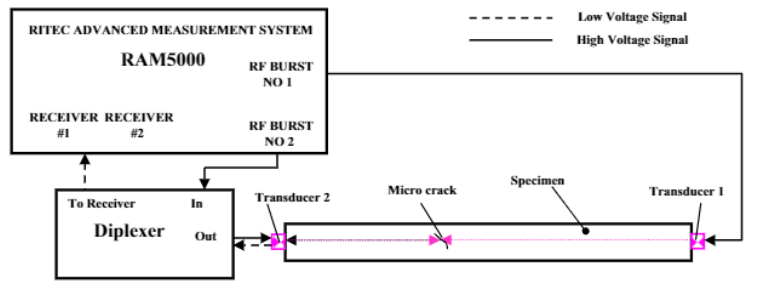
Figure 5. Schematic diagram of the experimental setup for collinear wave mixing. Reprinted from NDT & E International, Volume 62, Jiao, J.; Sun, J.; Song, G.; Wu, B.; He, C. Micro-crack Detection Using a Collinear Wave Mixing Technique, Page 122–129, Year 2014 with permission from Elsevier [54].